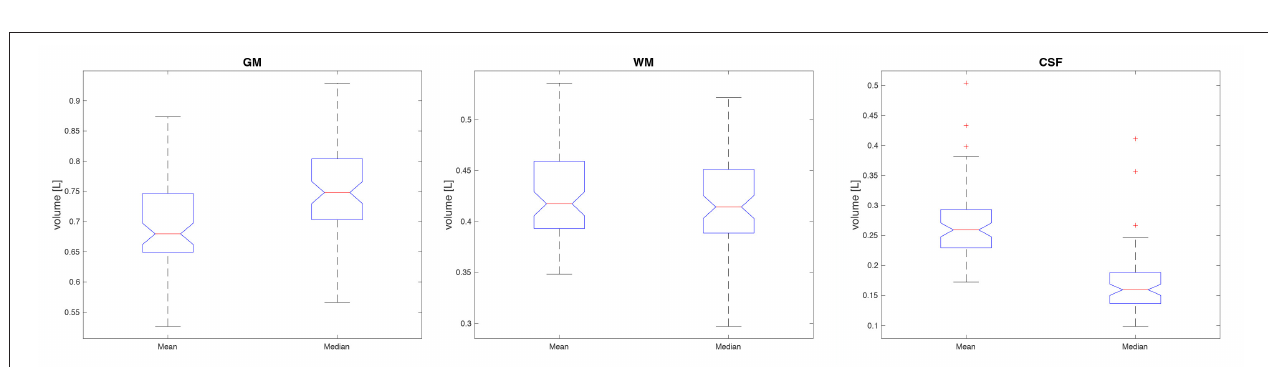
FIGURE 9 | The percentage differences in GM (left) , WM (middle) , and CSF (right) .